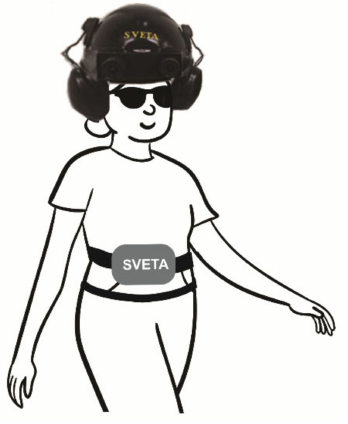
Figure 1. SVETA prototype and blind person wearing SVETA